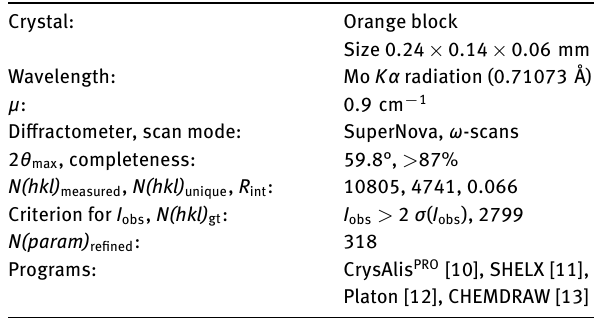
Table 1: Data collection and